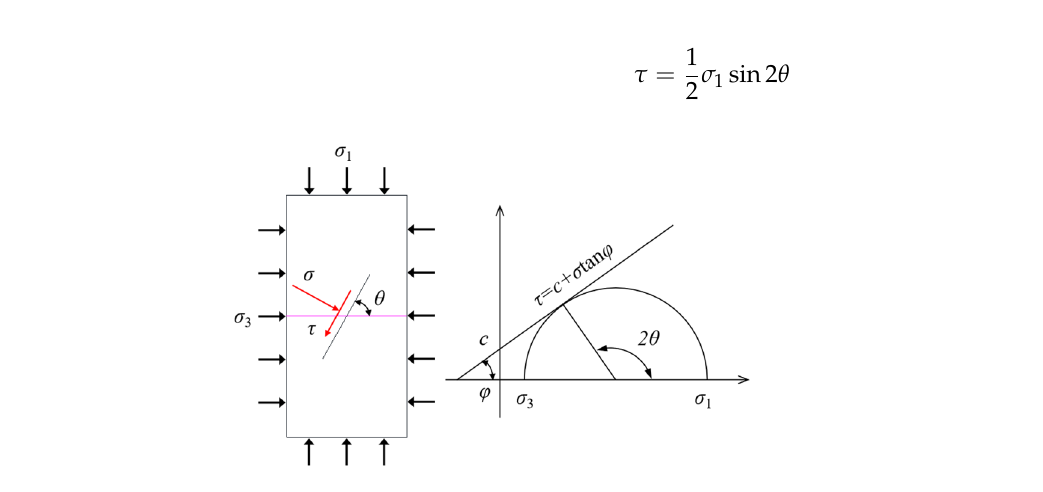
Figure 11. Strength analysis of single crack plane.